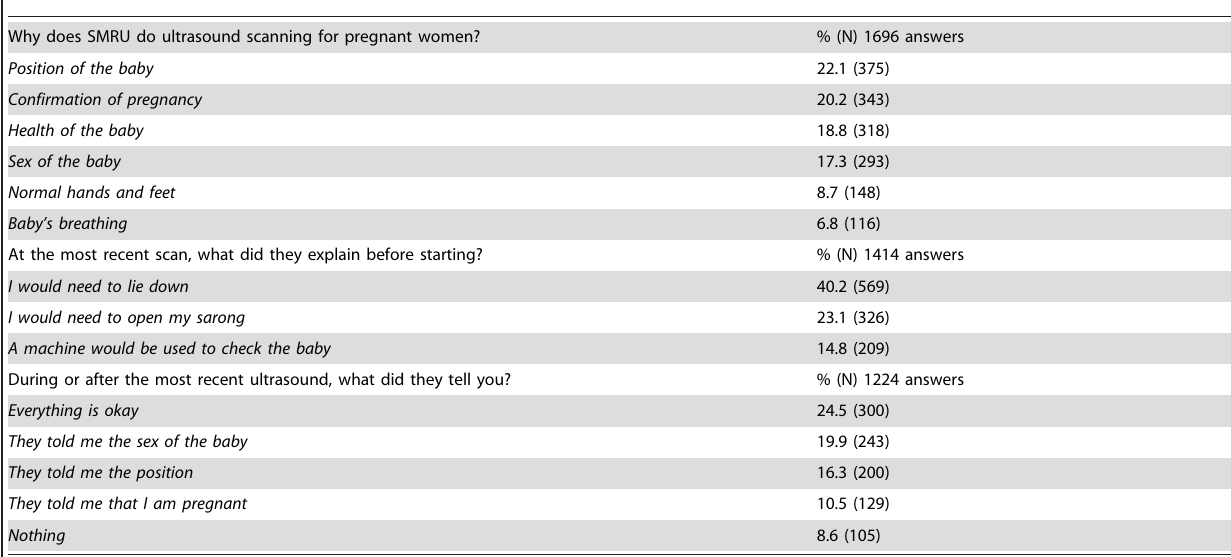
Table 2. Responses to open questions in a questionnaire among 644 pregnant women on the Thai Burmese border.